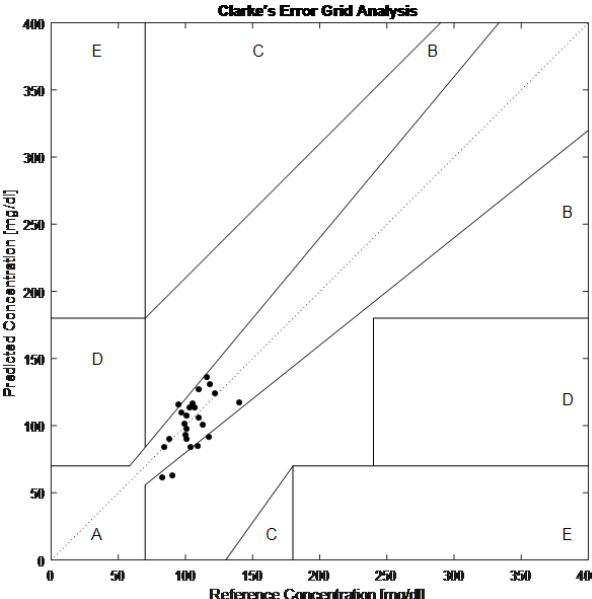
Table 1. Multiple regression analysis results.